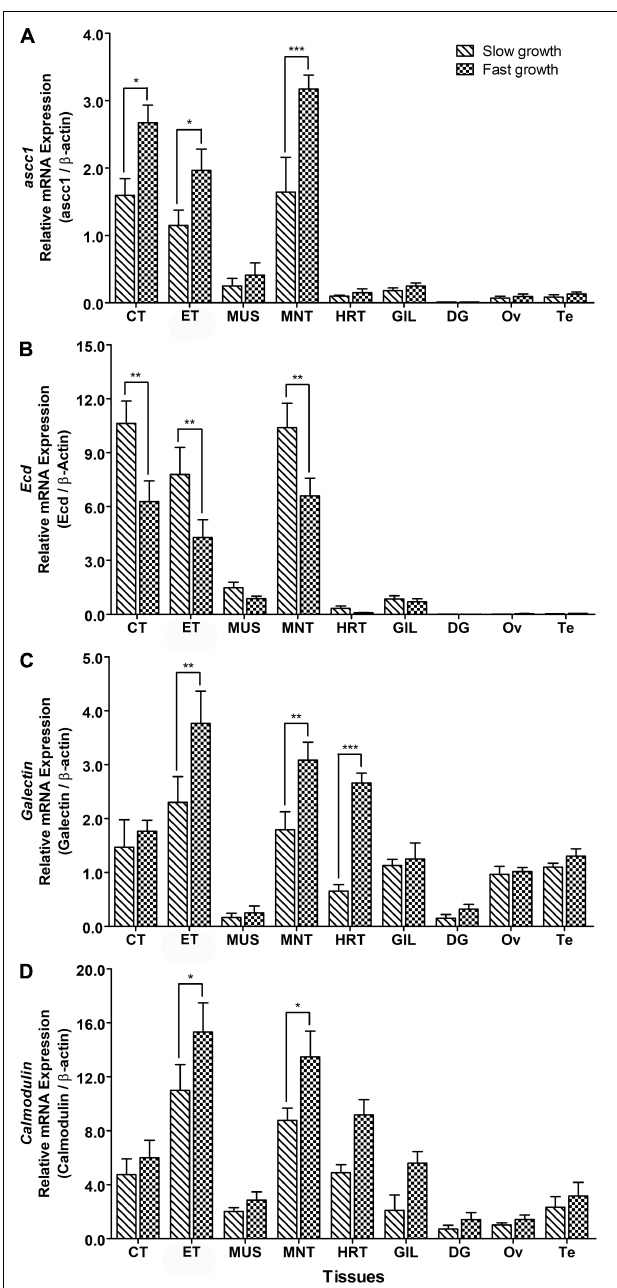
FIGURE 4 | Relative mRNA expression levels of (A) ascc1 , (B) Ecd , (C) Gal-4 and (D) CaM-B in different tissues of abalone with slow for fast growth. Asterisks indicated significant differences between slow and fast growth groups ( p < 0.05). CT, cephalic tentacle; ET, epipodial tentacle; MUS, muscle; MNT, mantle; HRT, heart; GIL, gill; DG, digestive gland; Ov, ovary; Te,